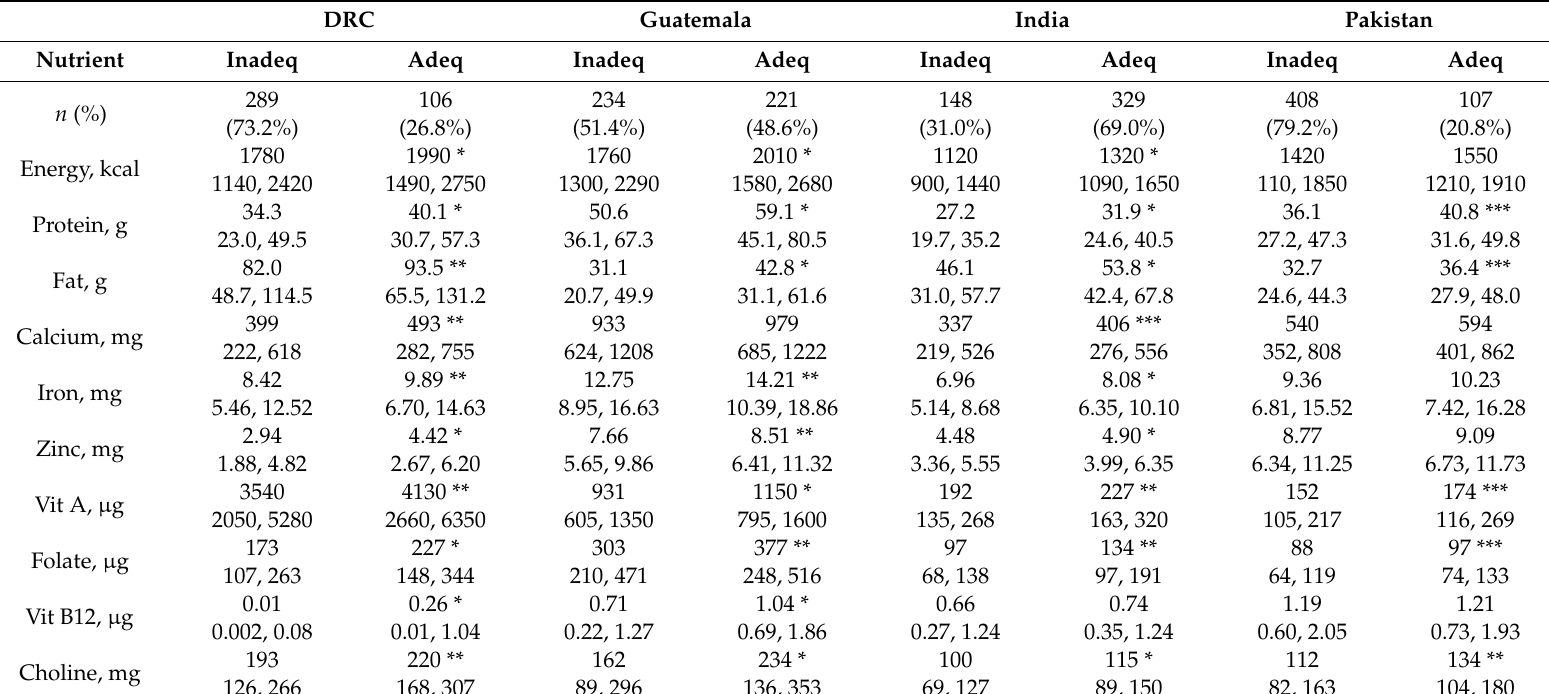
Table 4. Median, Q1, Q3 nutrient intakes 1,2 for inadequate vs. adequate dietary diversity in pregnant women from four low- and middle-income countries by site. DRC Guatemala India